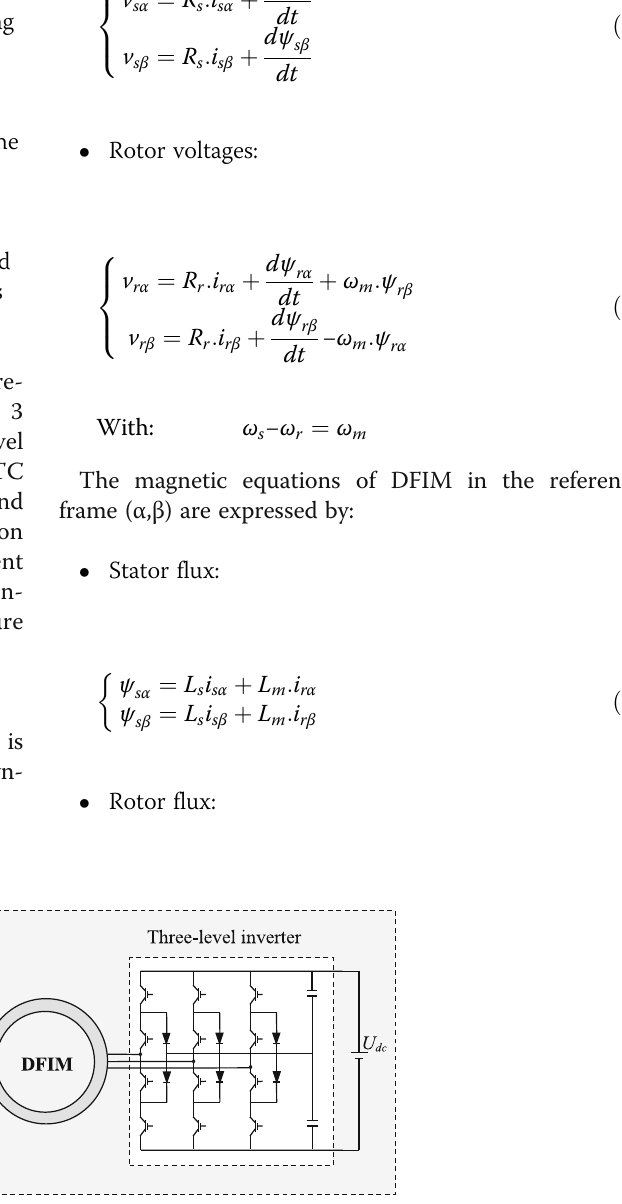
Fig. 1 Synoptic schema of studied